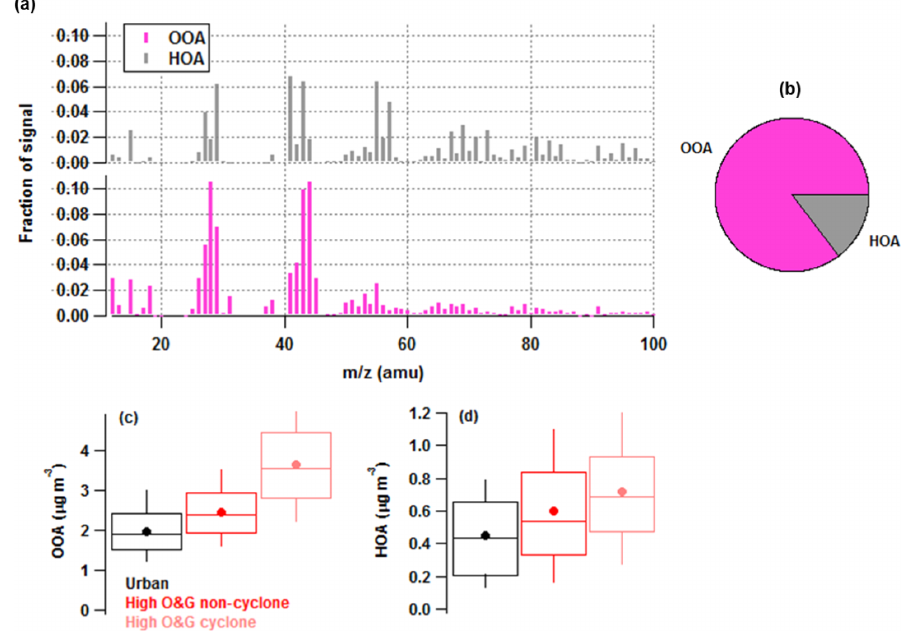
Figure 3. Mass spectra (a) , fractional contribution (b) , and mass concentrations of OOA (c) and HOA (d) factors. Box and whisker plots depict the 10th, 25th, 50th, 75th, and 90th percentiles. Mean values of OOA and HOA in each plume type are shown in circles.